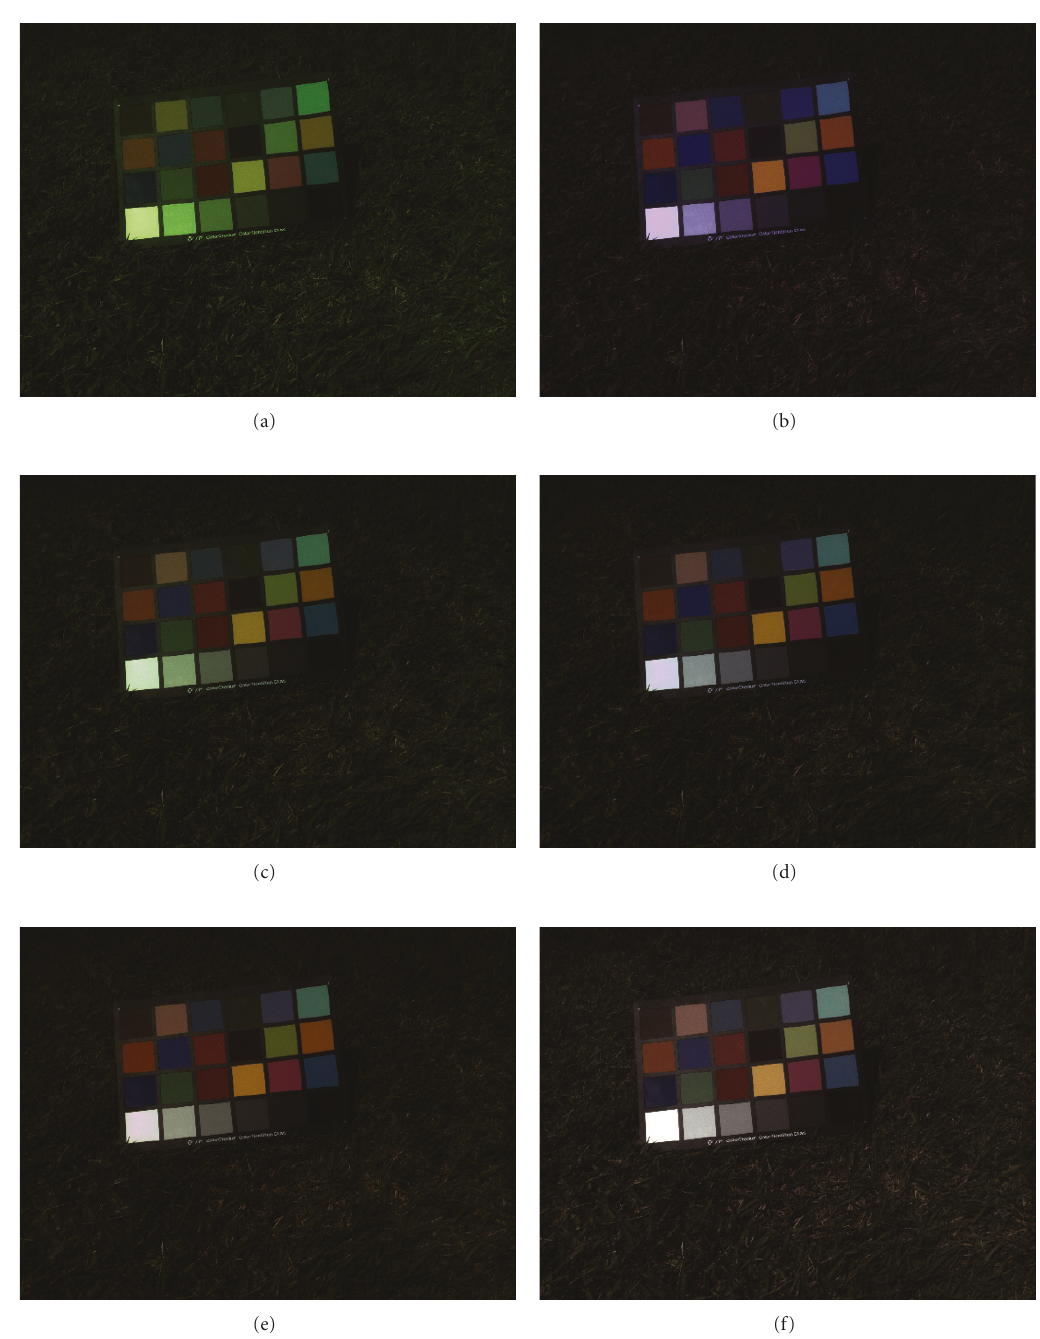
Figure 15: Result of the AWB method: (a) original image, (b) Gray world, (c) Max- RGB , (d) Shades of Gray, (e) Gray Edge, and (f) Proposed